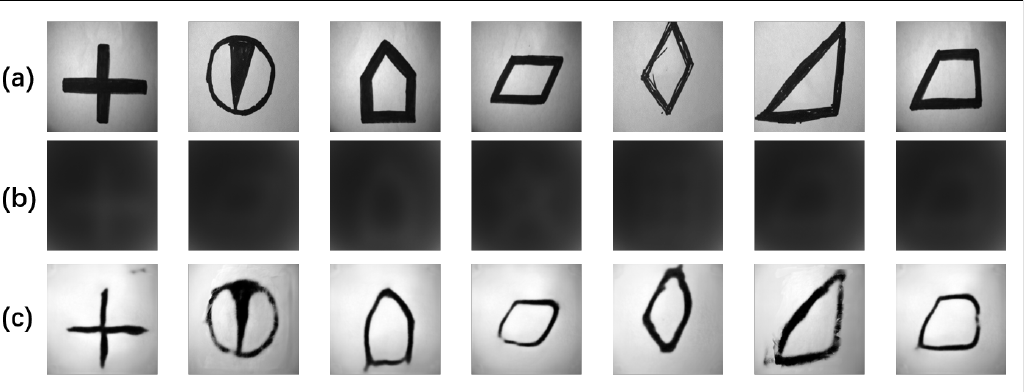
Figure 6. The reconstructed results for untrained graphic targets: ( a ) Ground truth; ( b ) Scattering DoP images; ( c ) Images reconstructed by the Model-DoP.